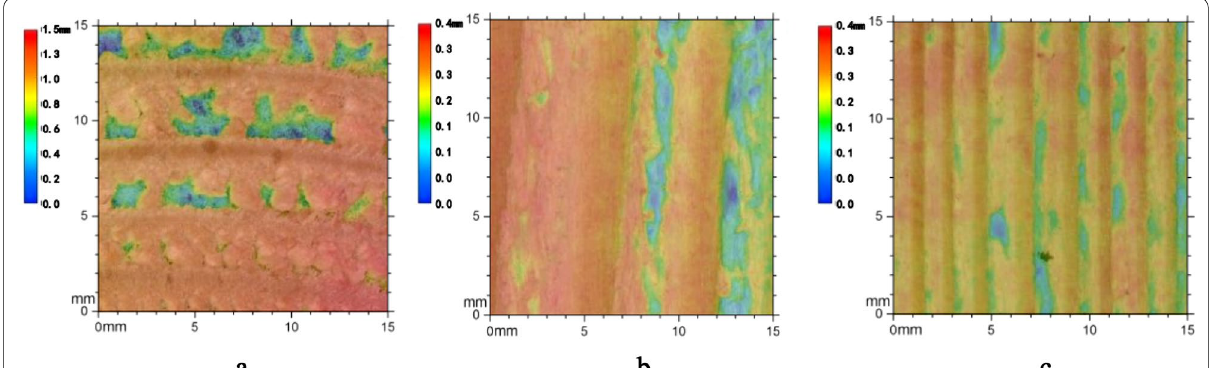
Fig. 9 3D profile of unpolished specimens: a transverse section; b tangential section; c radial section